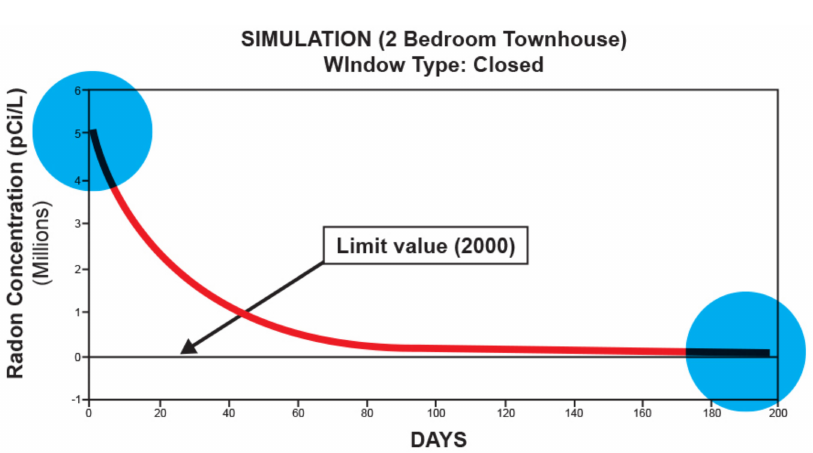
Figure 1. Changes in radon concentration with window